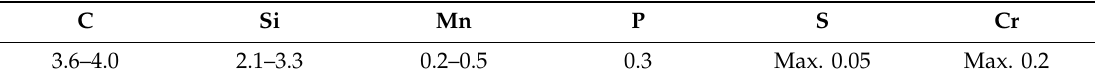
Table 1. Standardised Chemical Composition of S14 Nodular Cast Iron [% by Weight].